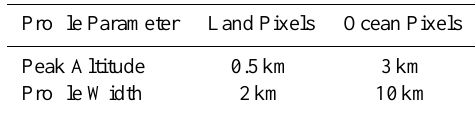
Table 2. Uncertainties associated to the profile shape